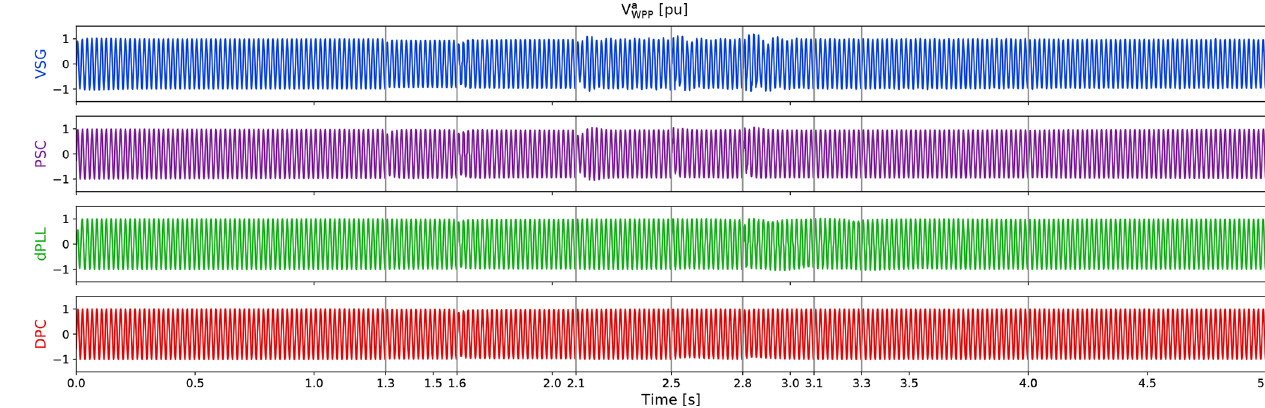
Figure 5. WPP output phase voltage (pu) for the different GFM control schemes.